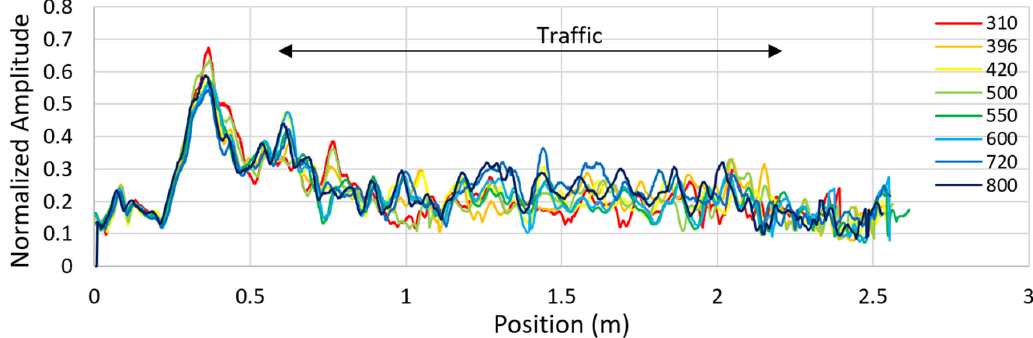
Figure 25. 2.6 GHz Normalized RW amplitudes on defects I-3 to I-1, in the longitudinal direction vs. K loadings.